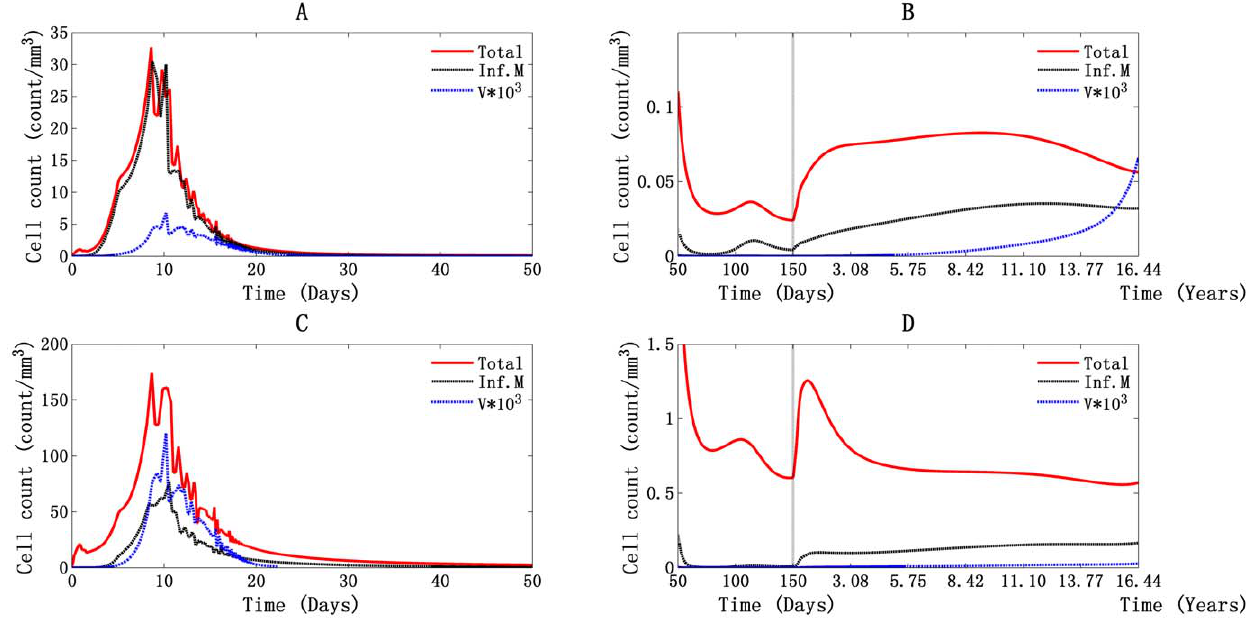
Figure 6. Illustration of the factors causing T4 cells death. Effects of macrophage-mediated, virus-mediated, and total uninfected T cell death in PB (A and B) and LNs (C and D), during the first 50 days (A and C) and from day 50 to day 6000 (B and D).